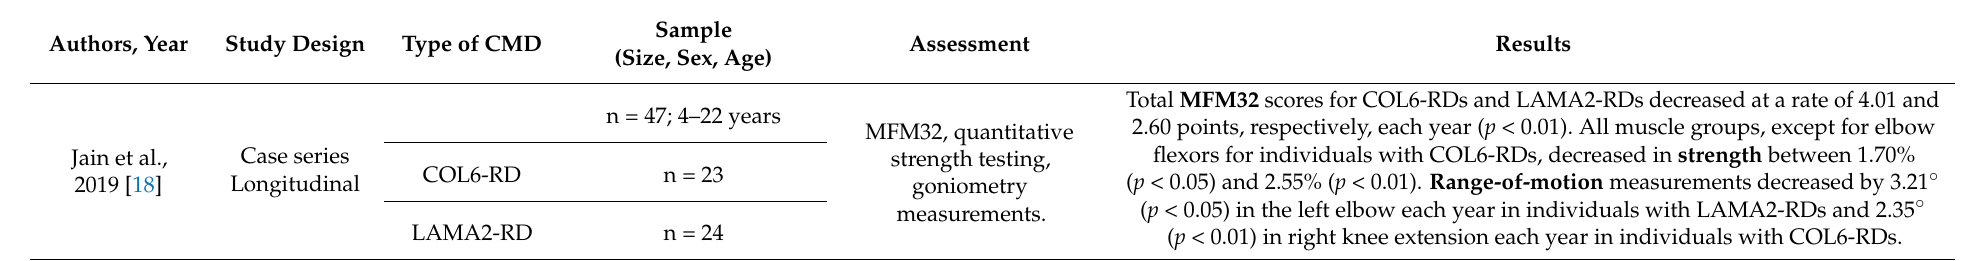
Table 7. Motor outcome measures in patients with congenital muscular dystrophies (MFM32: Motor Function Measure; Jebsen: Jebsen–Taylor Hand Function Test; QUEST: Quality of Upper Extremity Skills Test; HHD: Hand-Held Dynamometry; 6MWT: 6 min walk test; HFMS: Hammersmith Motor Function; NSAA: North Star Ambulatory Assessment; TFTs: timed function